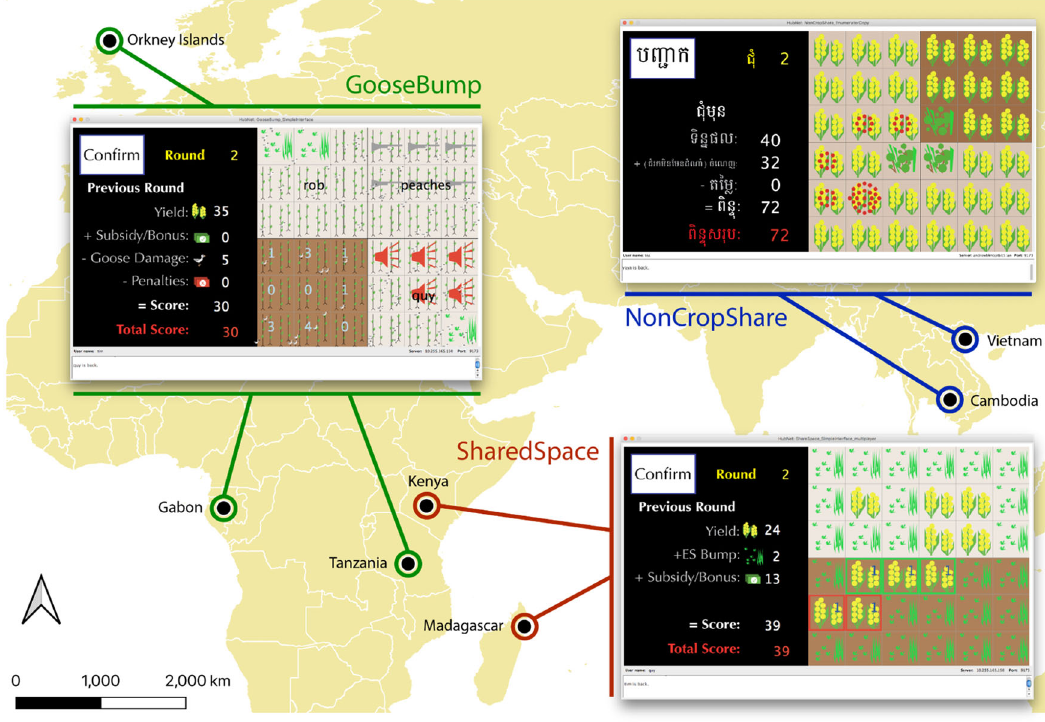
Fig. 1 Study sites for experimental games designed for collective action dilemmas in conservation, with sample client screens. NonCropShare datasets (blue) in Cambodia and Vietnam; GooseBump datasets (green) in Orkney, Gabon, and Tanzania; SharedSpace datasets (red) in Kenya and